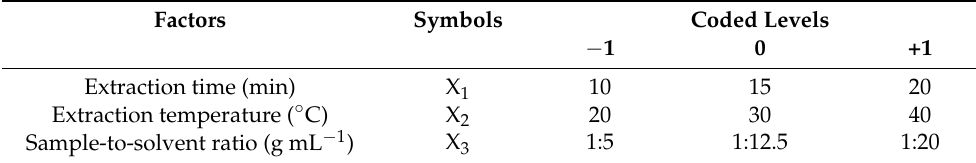
Table 6. Range and levels of experimental variables. Factors Symbols Coded Levels − 1 0 +1 Extraction time (min) X 1 10 15 20 Extraction temperature ( ◦ C) X 2 20 30 40 Sample-to-solvent ratio (g mL − 1